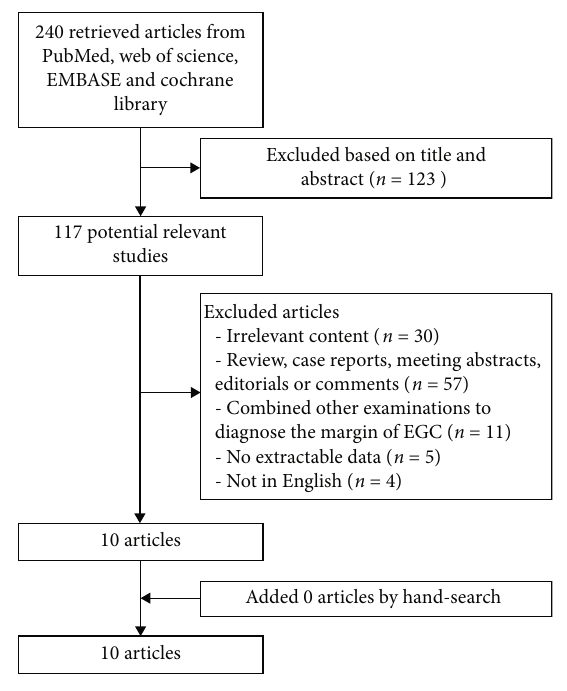
Figure 1: Flow diagram of study